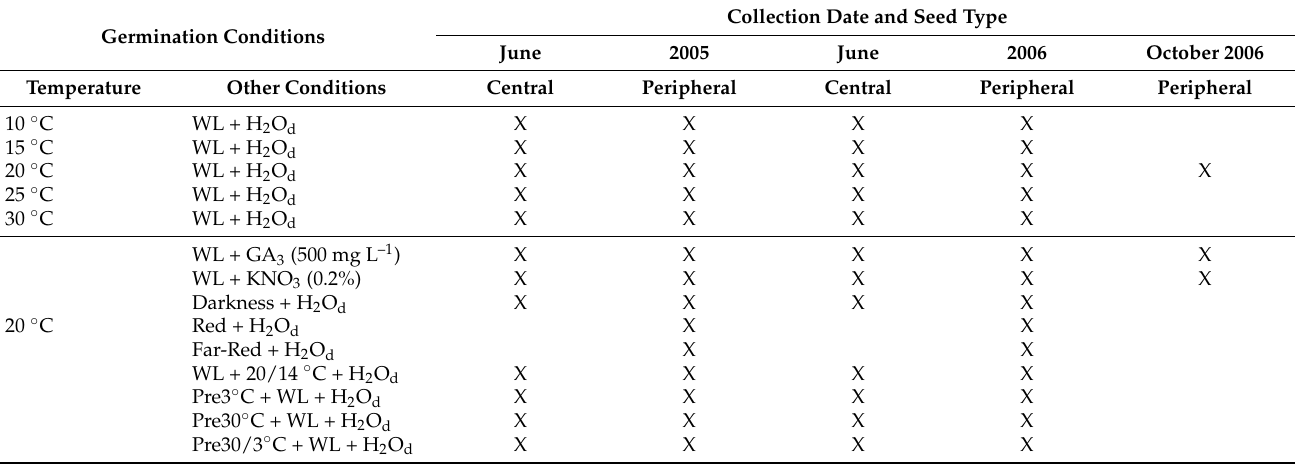
Table 13. List of the different germination tests carried out according to the germination conditions, pre-germination treatments, type of seed and collection date; 11 h